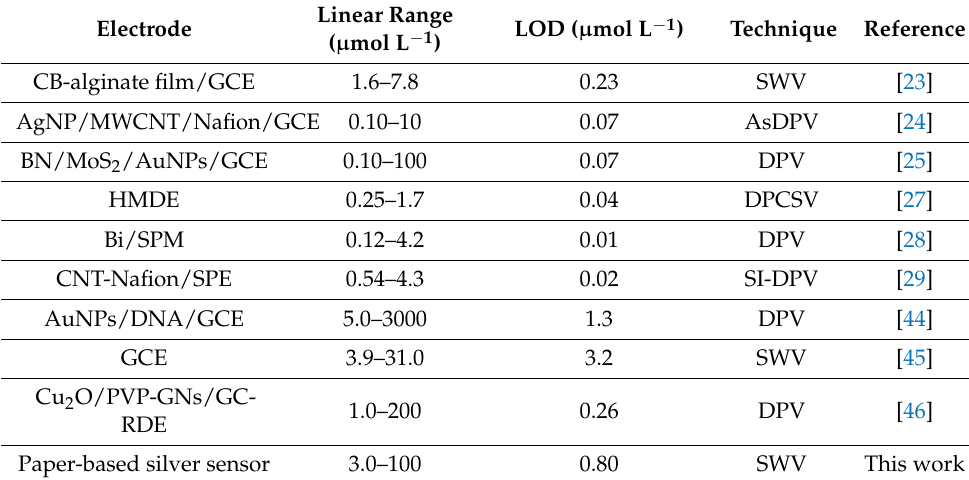
Table 2. Comparison of the performance of different chemically modified electrodes for the detection of paraquat (PQ).